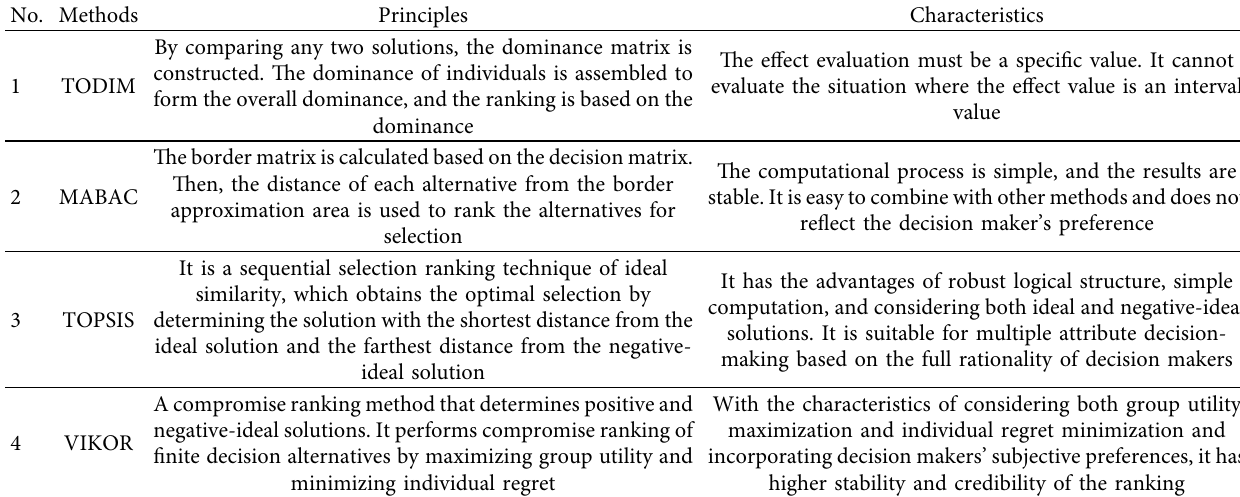
Table 1: Principles and characteristics of main research